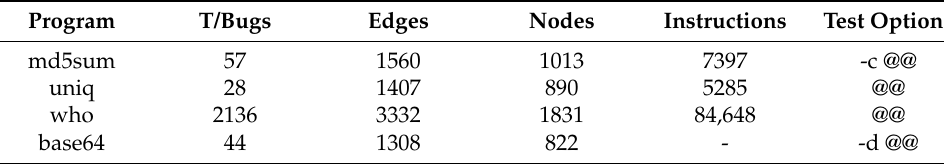
Figure 4. Evaluation of bug report analyzer approaches. Table 2. LAVA-M dataset details.